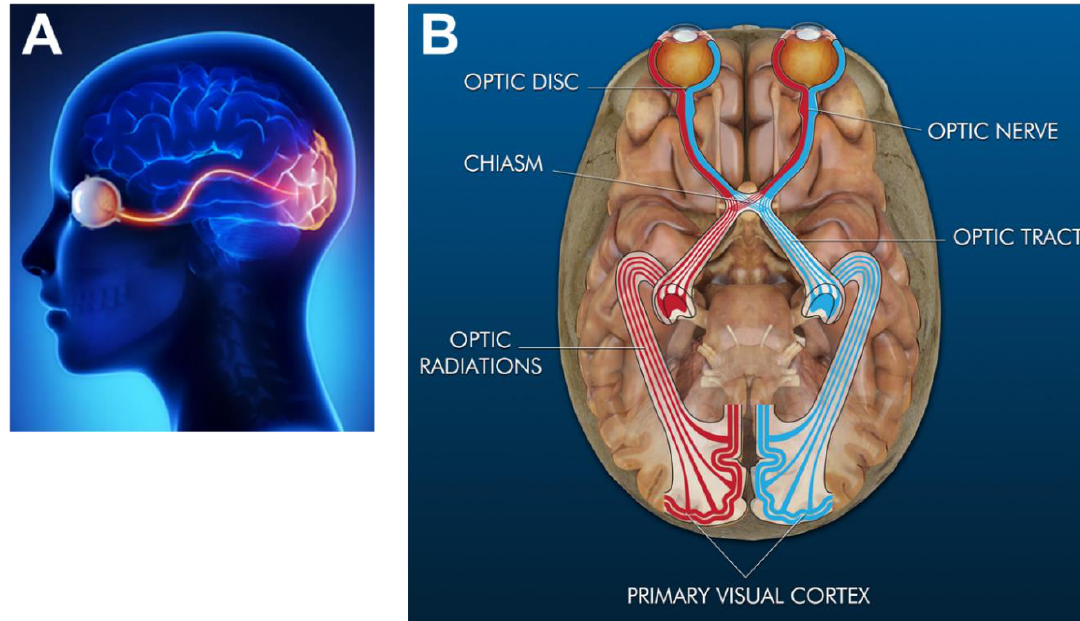
Figure 3. Simplified representation of the human visual system. ( A ) Sagittal plane (or side view) of the eye sensing organ and its connecting pathways to the visual cortex of the brain (highlighted in red) (Image reproduced with permission from The Discovery Eye Foundation). ( B ) Transverse rendering (or top view) of the primary components of the visual system overlaid onto the brain (Image reproduced with permission fromEyerudio Limited). The optic disc proceeds from the eye, where the axons of retinal ganglion exit to form the optic nerve. The optic nerve then connects to the optic chiasm, the X–shaped structure shown. The optic tract continues from the optic nerve and relays information to the optic radiations (or geniculocalcarine tract), which in turn transmit visual input to the primary visual cortex.